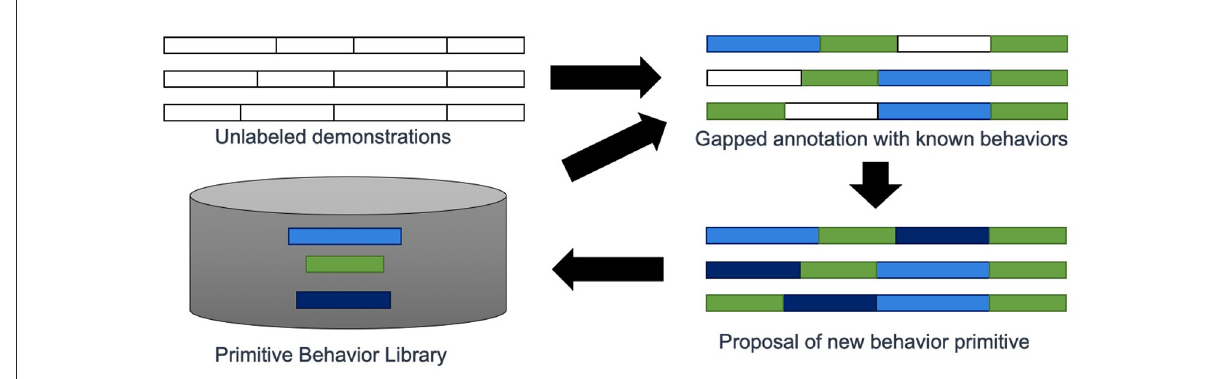
FIGURE2 An overview of PICO . The approach takes as input unlabeled demonstrations and a library of primitive behaviors. The goal is to predict the primitive behavior label associated with each time point in all demonstrations. Additional behavior primitive models can be trained to fill gaps that are not well-represented by existing behavior